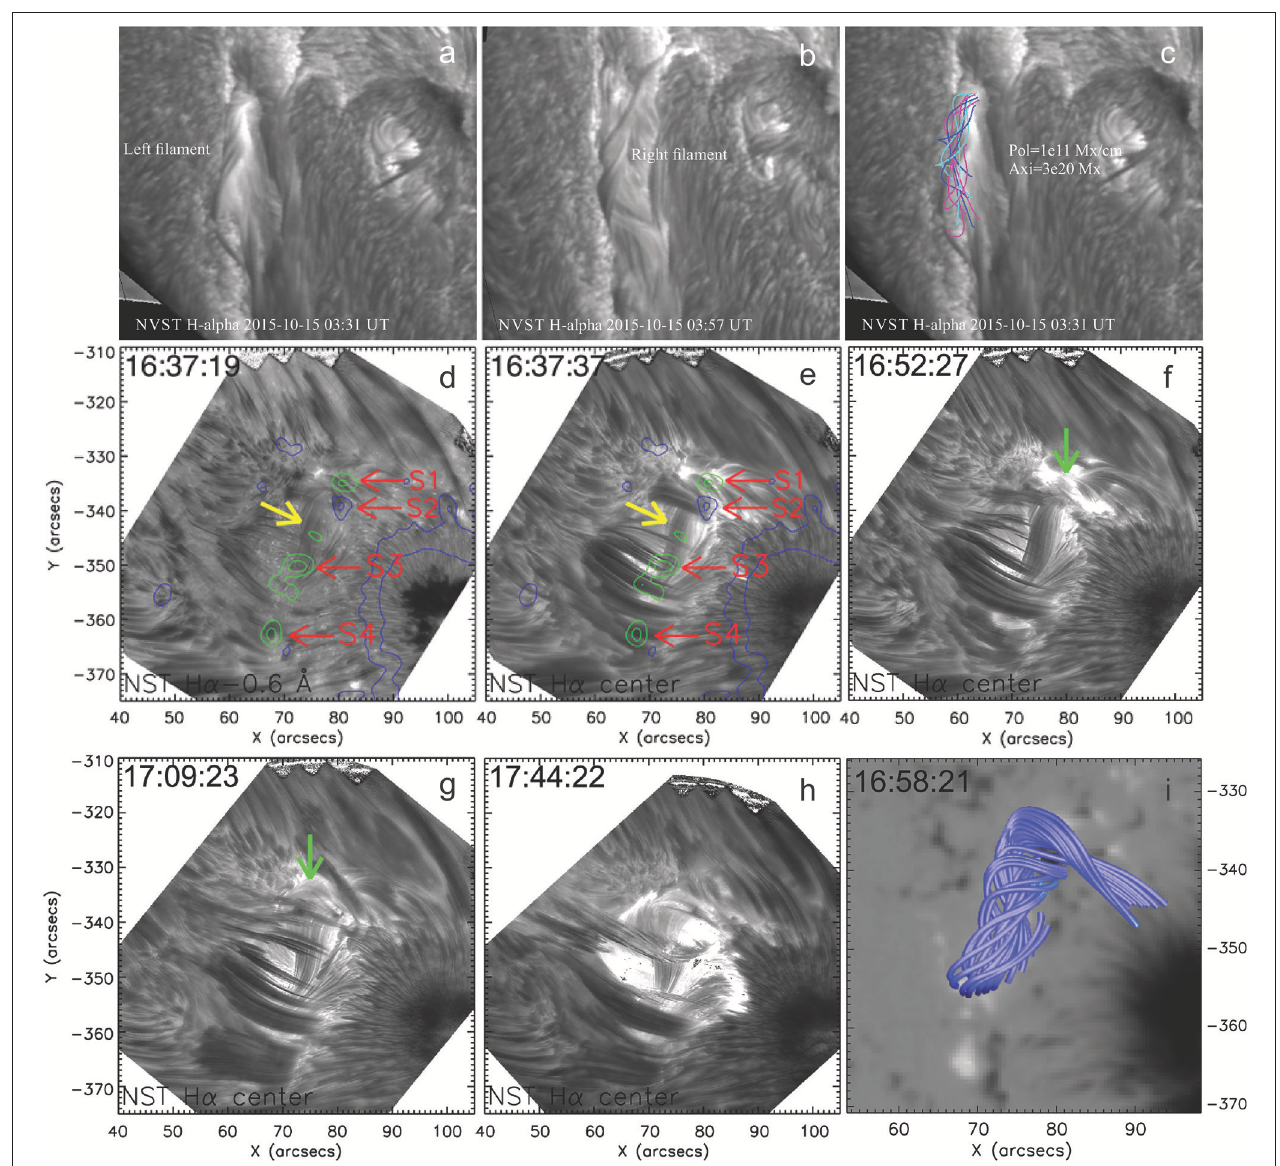
FIGURE 2 | (a–c) NVST observations of two near-limb active filaments with clear twist structure in NOAA active region 12434 on 2015 October 15 and the NLFFF extrapolation model of the left filament. The poloidal and axial fluxes used by the flux-rope-insertion method are indicated. The model of the right filament is similar (Li et al., 2017). (d–i) BBSO/GST H α − 0.6 Å and H α center observations and optimization NLFFF model of a small-scale emerging flux rope in NOAA active region 12403 on 2015 August 24 that drives an M1.0 flare and a CME. The green (blue) contours represent small satellite sunspots (pointed to by the red arrows) in positive (negative) polarity field. The yellow and green arrows point to the flux rope and its upper portion, respectively (Yan et al., 2017). Reproduced by permission of